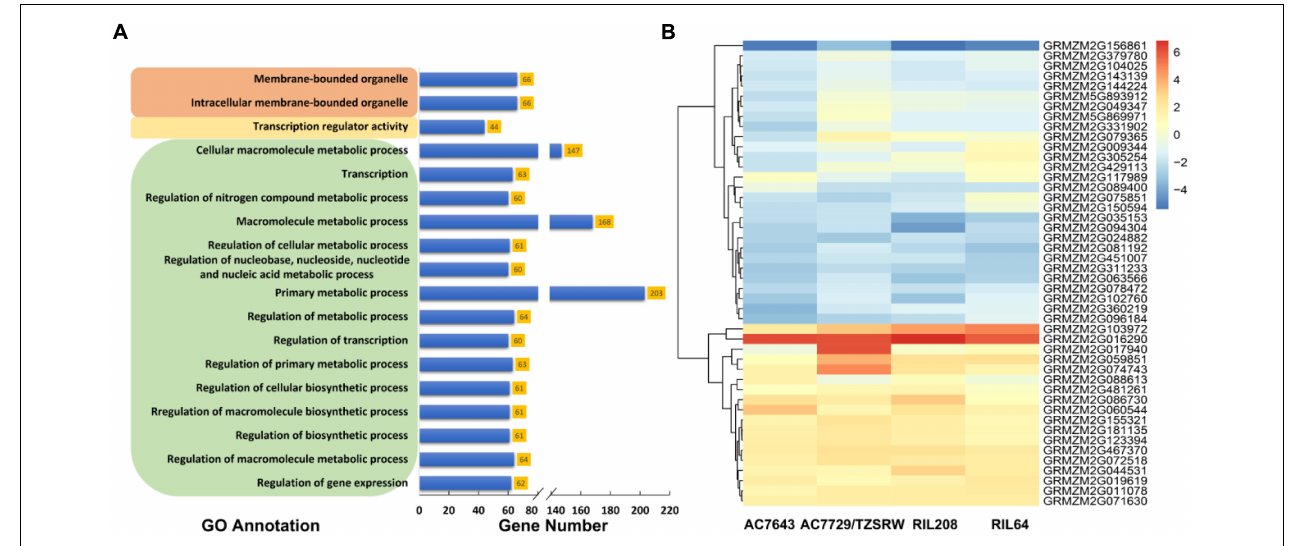
FIGURE 5 | The results of gene ontology (GO)-based functional enrichment analysis (A) and the expression profiling analysis (B) . The GO terms in brown, yellow, and green colored boxes are cellular component, molecular function, and biological process categories, respectively. AC7643 and RIL208 are drought